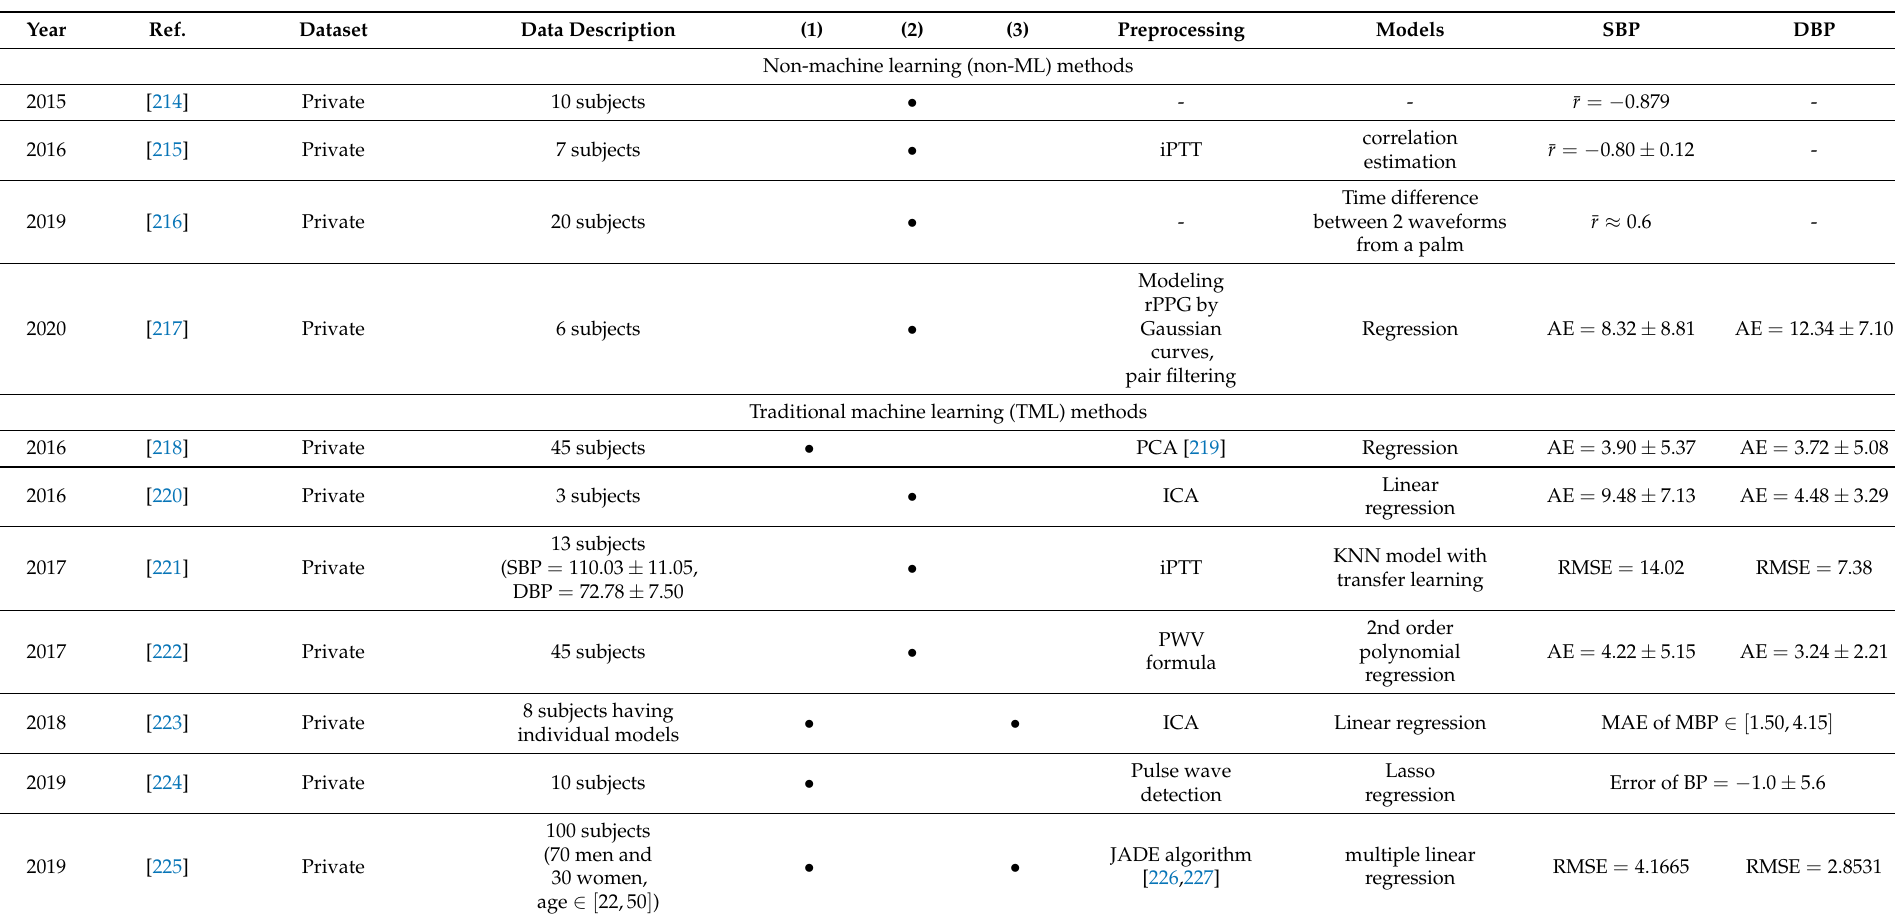
Table 4. Non-ML, TML, and DL models using rPPG signals as inputs. The units of SBP and DBP (unless specified) are mmHg. AER = average error